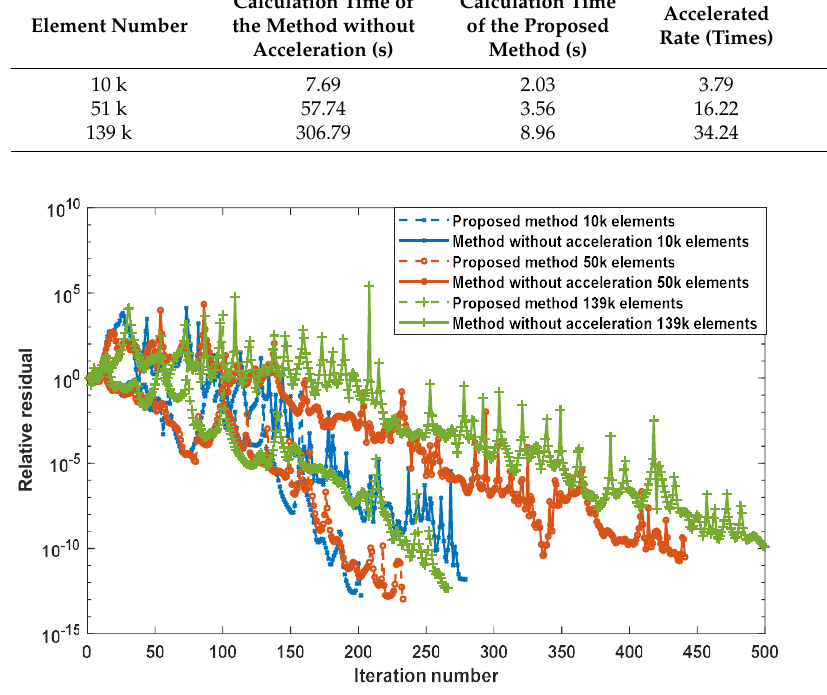
Figure 5. The relative residual with different mesh elements [22].